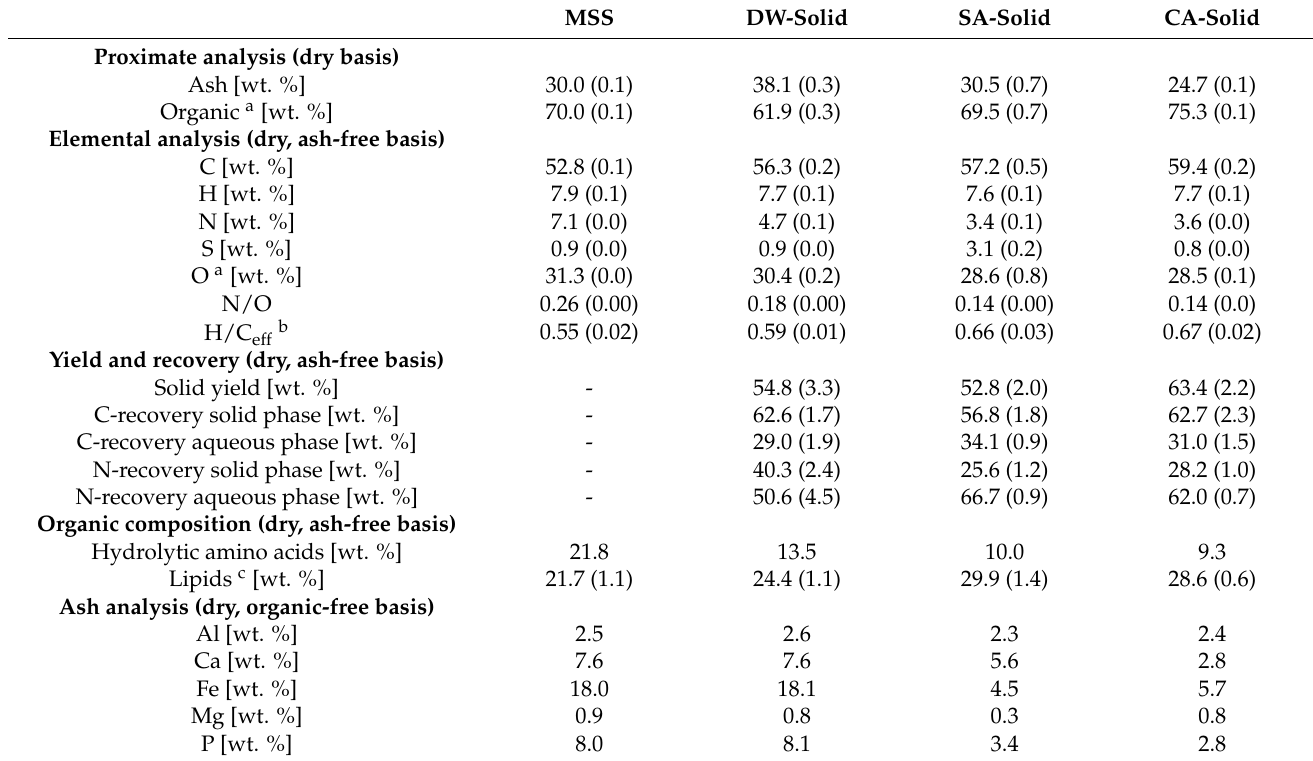
Table 1. Characterization of the feedstock (MSS) and pre-treated solids (DW, SA, CA). The values in brackets indicate the standard deviation. MSS DW-Solid SA-Solid